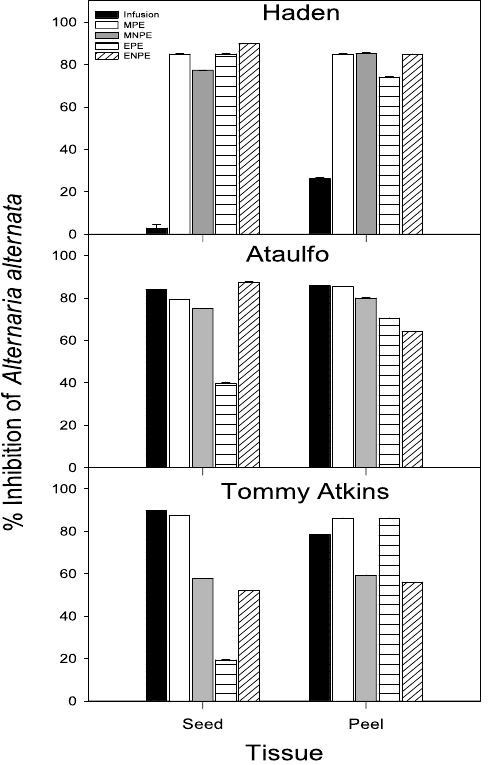
Fig. 3: Inhibition percentage of mycelial growth of Alternaria alternata at day 5. *Concentration 6.25 mg/mL. **Average of three deter- minations ± standard